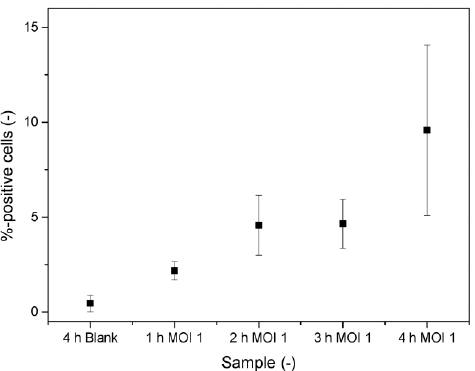
Figure 4. Quantification of the percentage of fluorescing cells after BV infection and fluorescent labeling of the mRNA of the viral gp64 protein within the first four hours of infection. A multiplicity of infection (MOI) of 1 was used and compared to a negative control without virus infection (error bars indicate the standard deviation of technical triplicates).